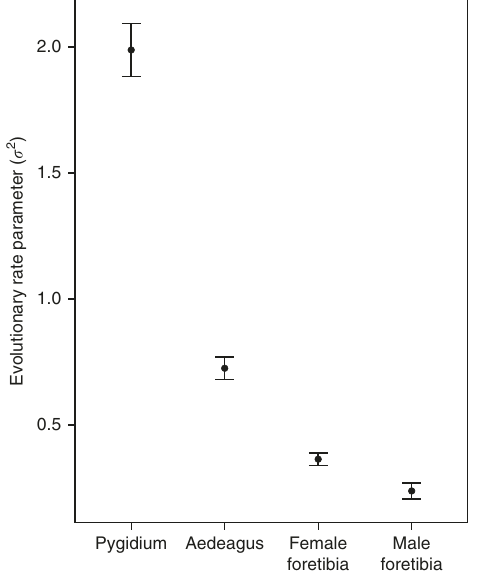
Fig. 3 Phylogenetic rate of shape evolution of male and female genitalia and foretibia. Evolutionary rate parameters ( σ 2 ) and their 95% con fi dence intervals are presented for the pygidium, aedeagus and female and male foretibia. Post hoc pairwise comparisons revealed signi fi cant differences in the rate of evolution among all genitalia and foretibia shapes